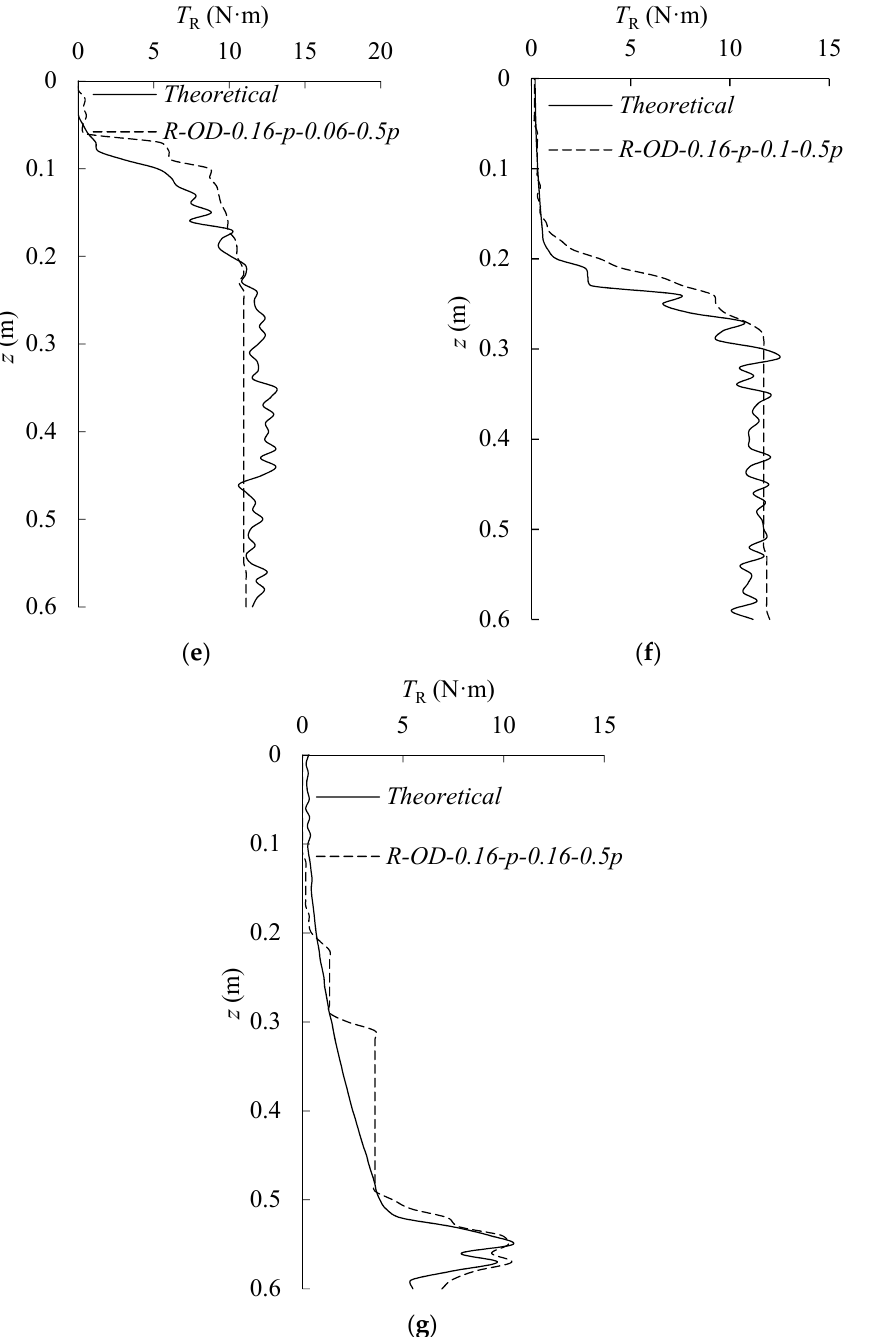
Figure 13. The comparative results between test and theoretical results. ( a ) TN-1, ( b ) TN-2, ( c ) TN-3, ( d ) TN-4, ( e ) TN-5, ( f ) TN-6, and ( g ) TN-7.